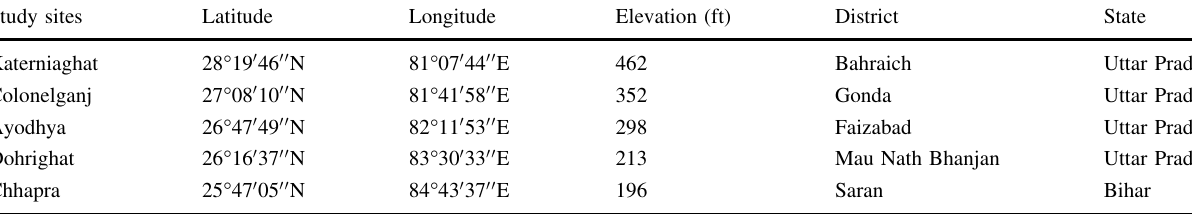
Table 1 Sampling sites at River Ghaghara with their geographical co-ordinates Study